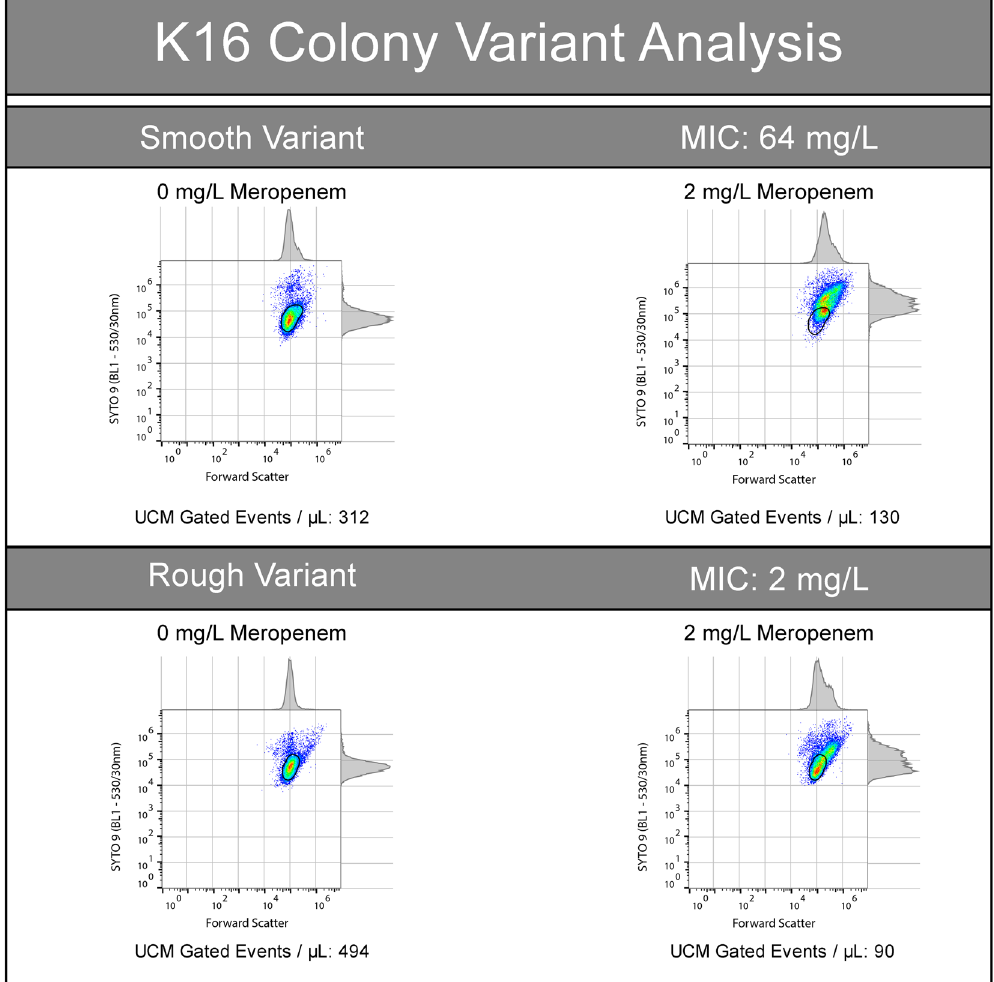
MIC FAST results were concordant with the MIC BMD